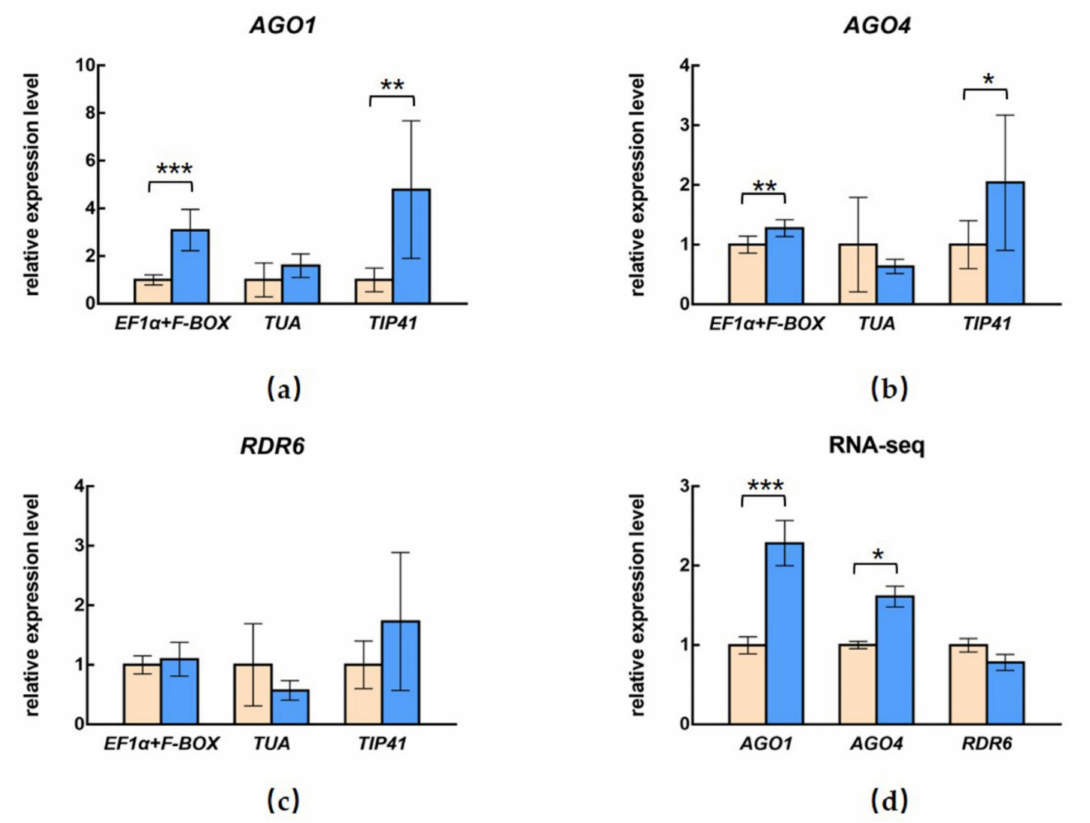
Figure 6. Relative expression of ( a ) AGO1 , ( b ) AGO4 , and ( c ) RDR6 in PNRSV-infected C. sativus with different reference genes. EF1 α and F-BOX were the most stable genes, while TIP41 and TUA were the least stable genes. ( d ) The relative expression levels of AGO1 , AGO4 , and RDR6 were calculated by high-throughput RNA sequencing data. * means p < 0.05, ** means p < 0.01, and *** means p < 0.0001 (based on t-test